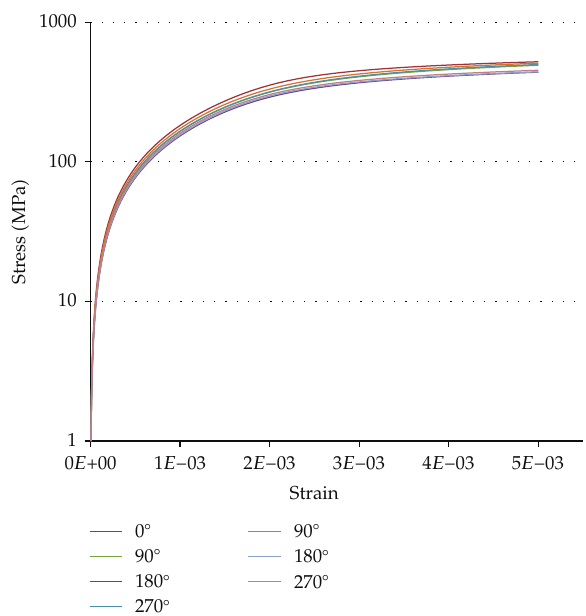
Figure 7: Some experimental stress-strain curves from samples taken along the pipe section (cid:6) Tata, 2010 (cid:7) .